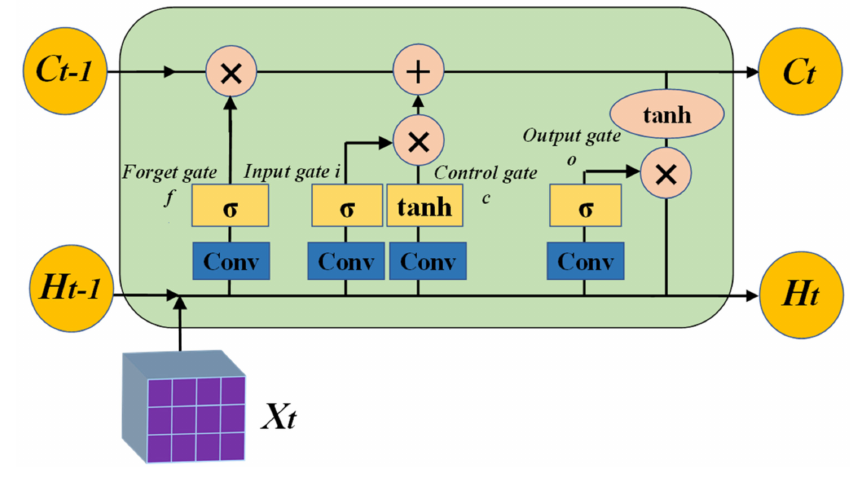
Figure 2. Structure of ConvLSTM cell.